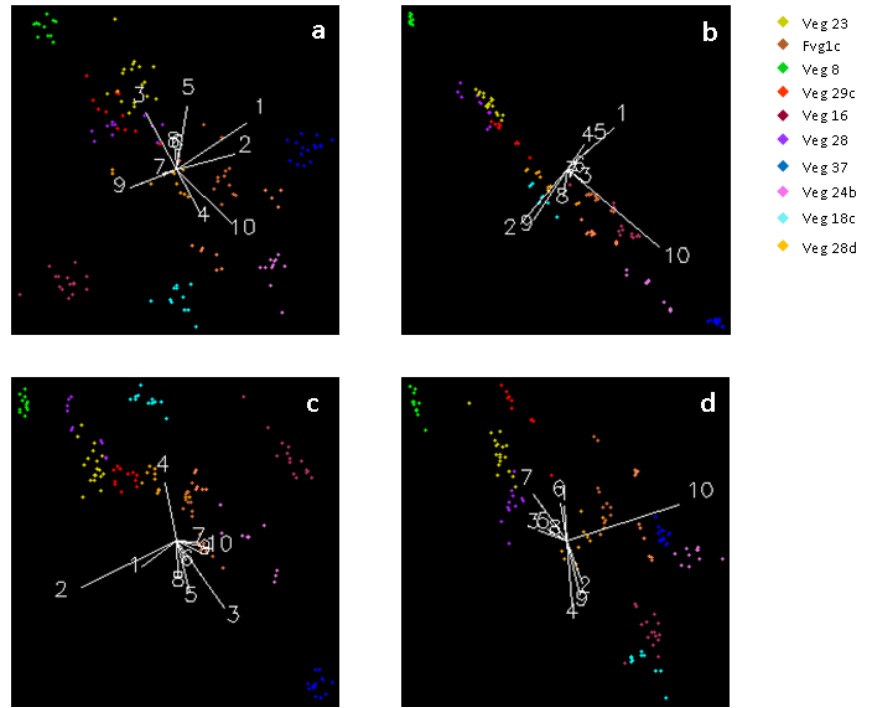
Figure 6. ROI scatter plot in the 10-dimensional space as visualized from different rotation angles. There are more than 50 possible view angles for this scatter plot due to the 10 bands axes. The axes labelled 1 to 10 represent each Sentinel 2 band in order from band 2 to band 12 as shown in figure 5 above. ( a – d ) We sampled these four views to visually illustrate how the different ROI pixel positions are visible with as minimal overlap as possible. The clustering of the different ROI pixels was important in distinguishing and discriminating between ROI classes.